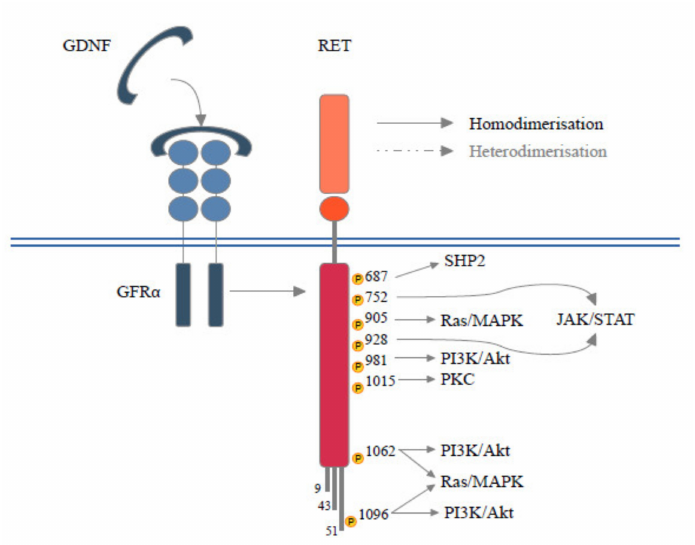
Figure 1. Schematic RET protein structure showing phosphorylation sites. RET forms a heterocom- plex with GFR α and GFLs proteins, which in turn results in the activation of multiple signaling pathways involved in survival, differentiation, motility, proliferation, and